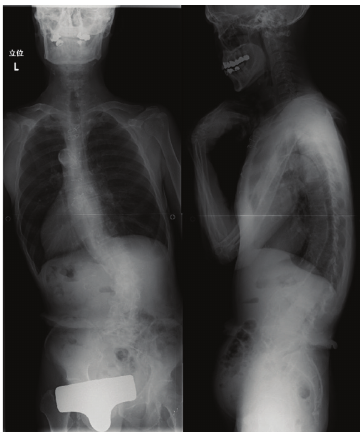
Figure 3: Preoperative radiographs showing right convex lumbar curvature and left-side coronal